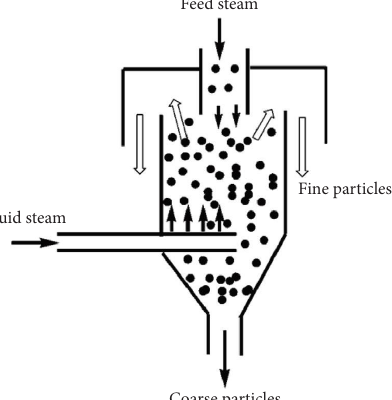
Figure 5: Air elutriation mechanism of coarse